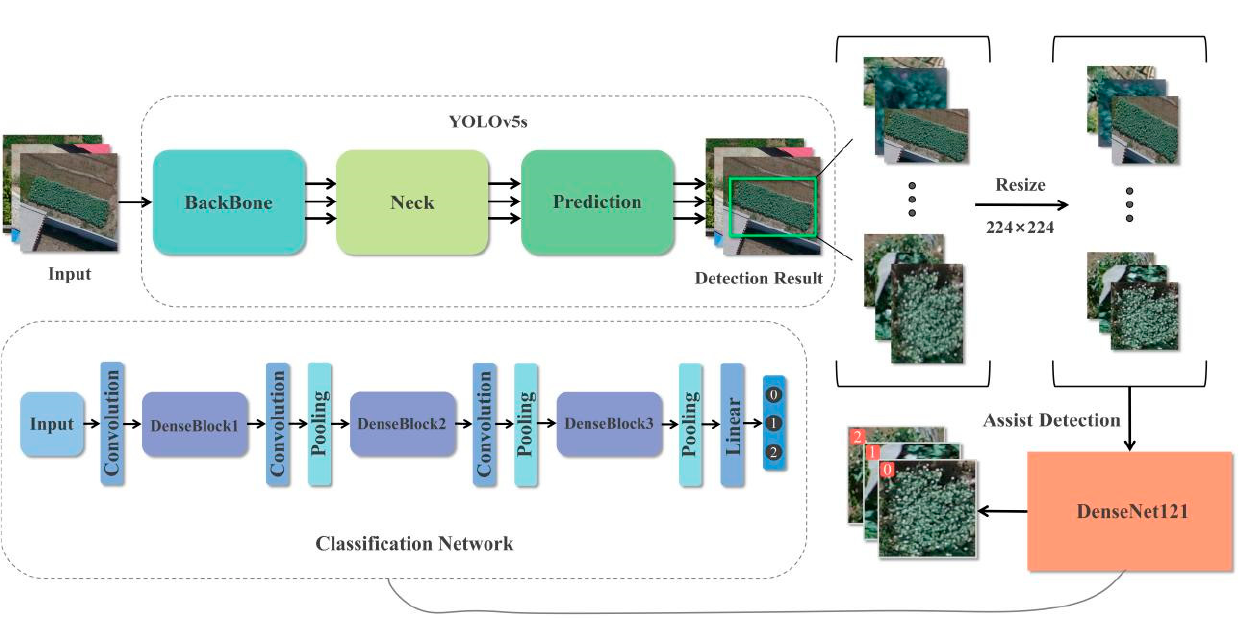
Figure 4. Two-stage network structure.